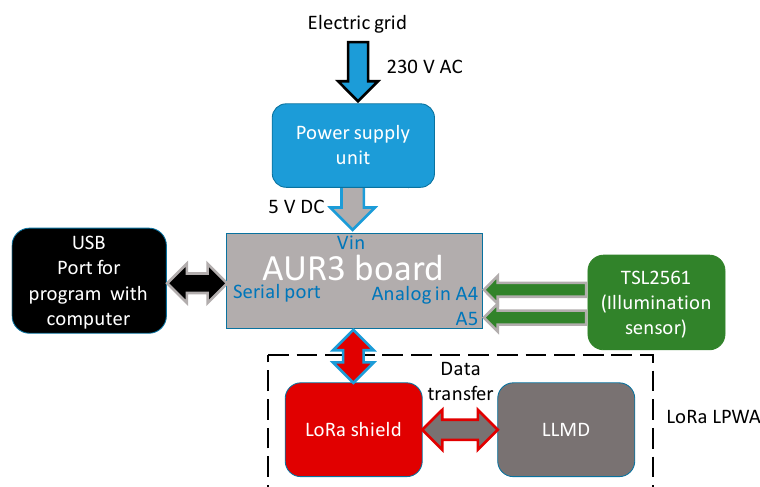
Figure 6. Hardware block diagram of LLMD.